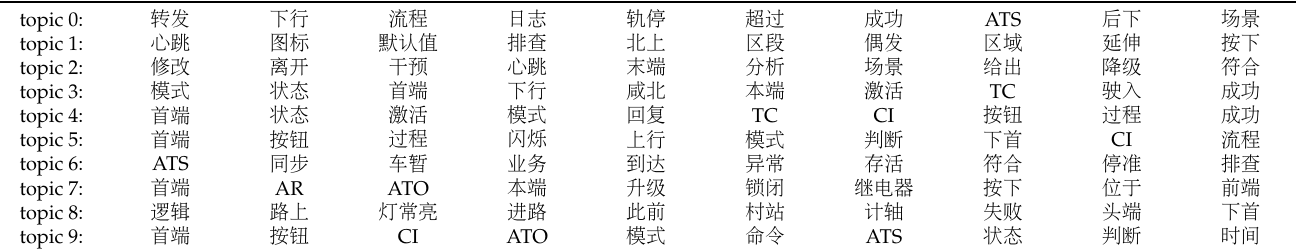
Table A2. Topic analysis of ATB in Chinese.